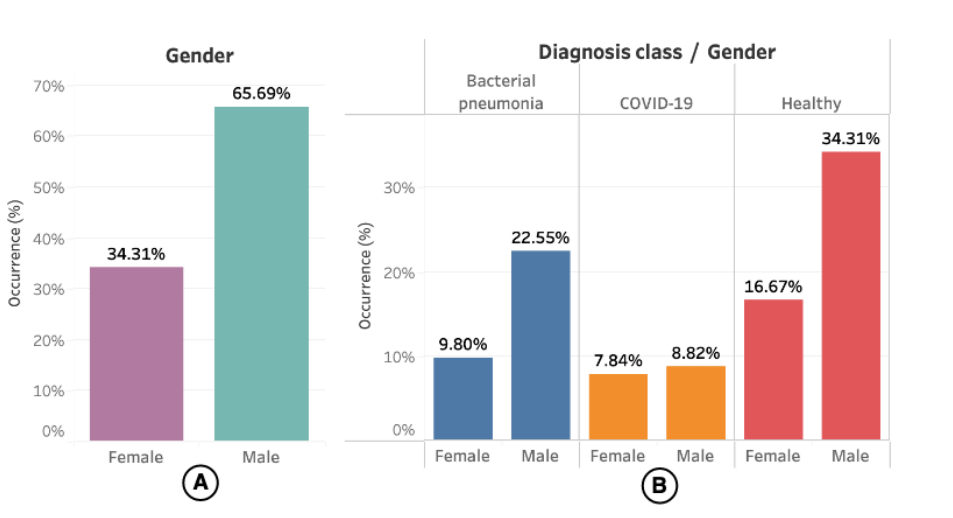
Figure 3. ( A ) shows the occurrence of gender in the LUS videos. ( B ) shows the occurrence of gender segmented by diagnosis class.